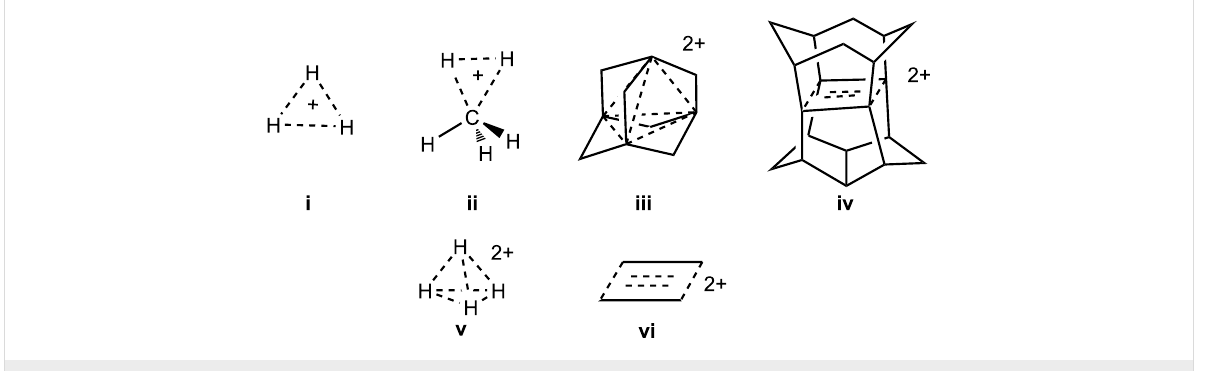
Scheme 1: Examples of 2e-3c and 2e-4c bonded